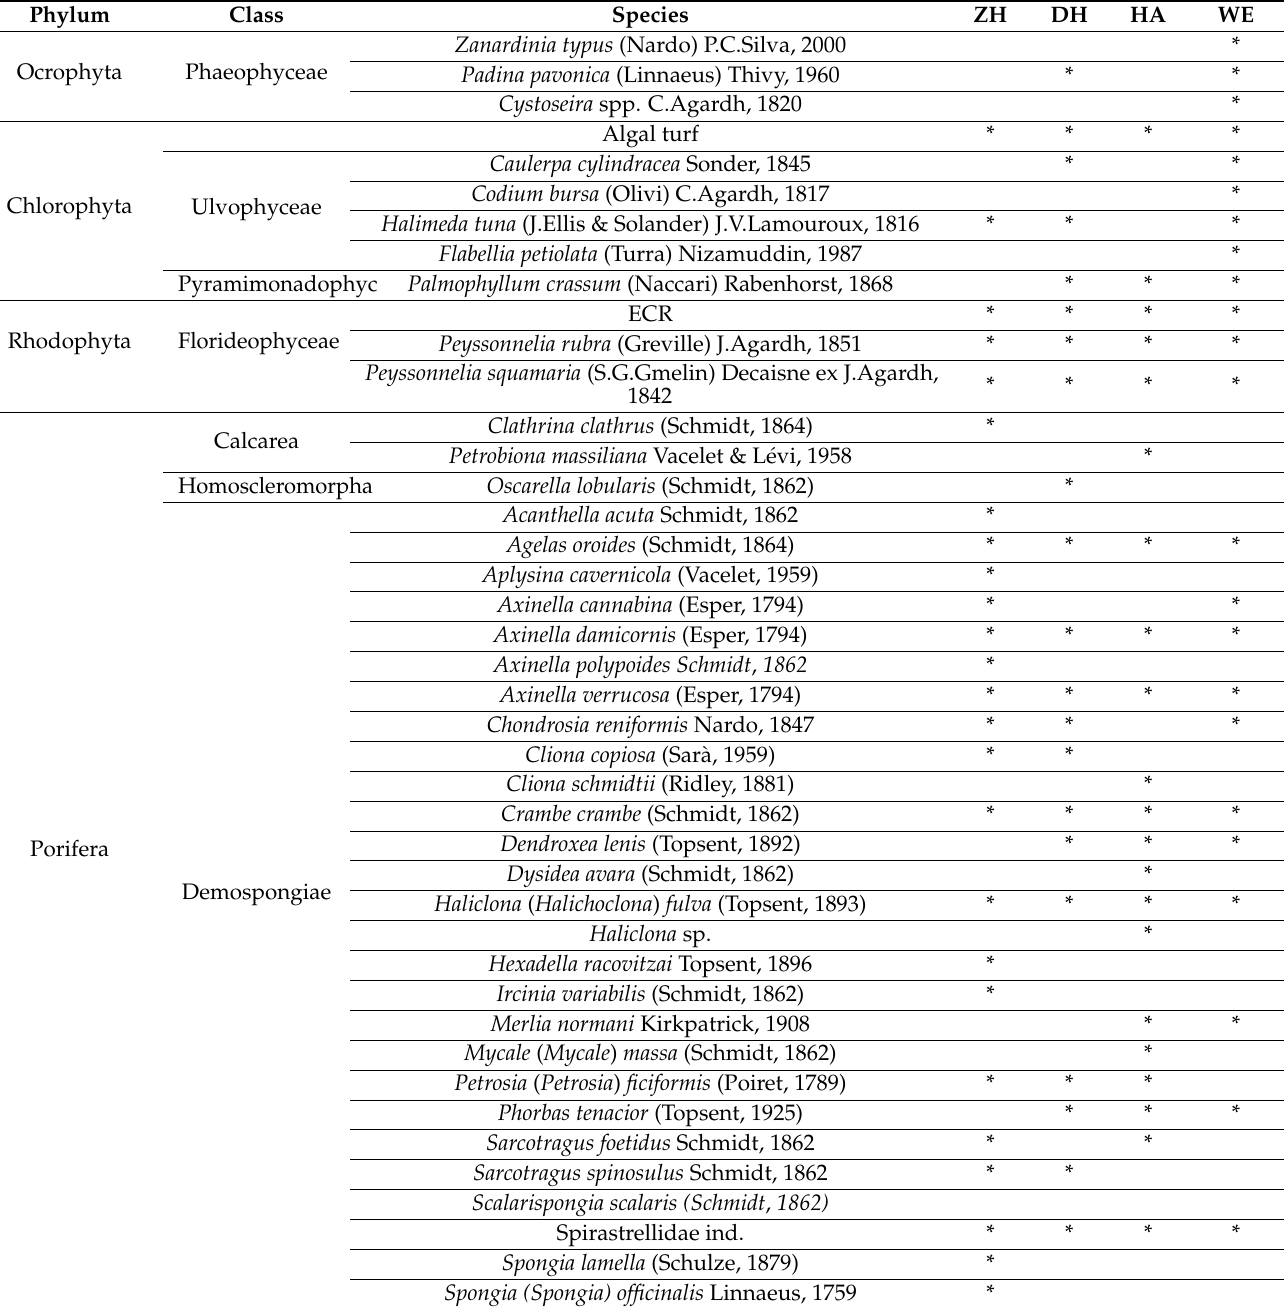
Table 2. Checklist of the benthic taxa recorded at each site (* = presence of